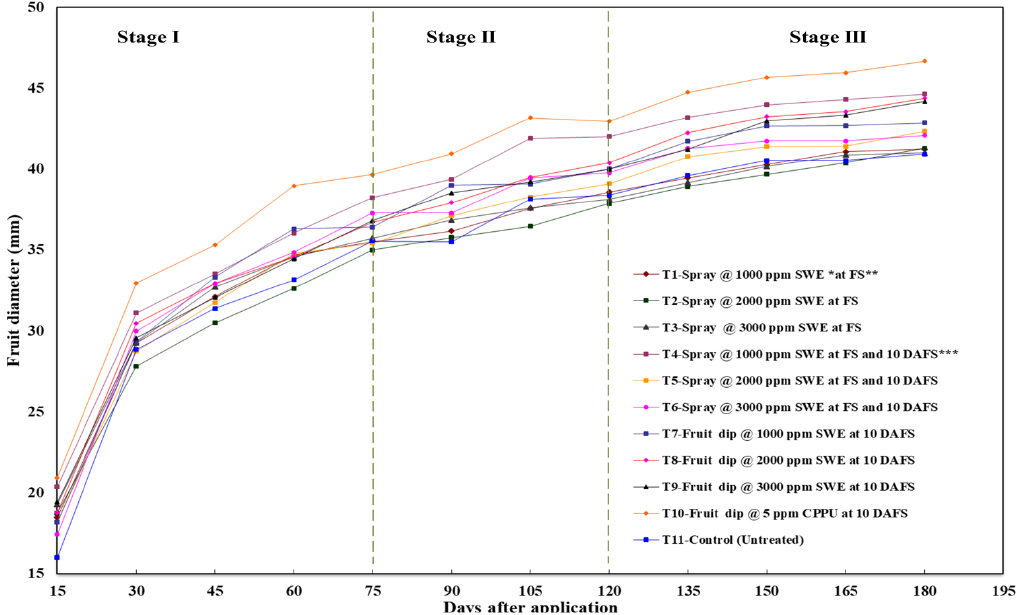
Figure 2. Impact of seaweed extract on the fruit growth pa tt ern of kiwifruit in terms of diameter. SWE*—Seaweed extract, FS**—fruit set, DAFS***—days after fruit set.